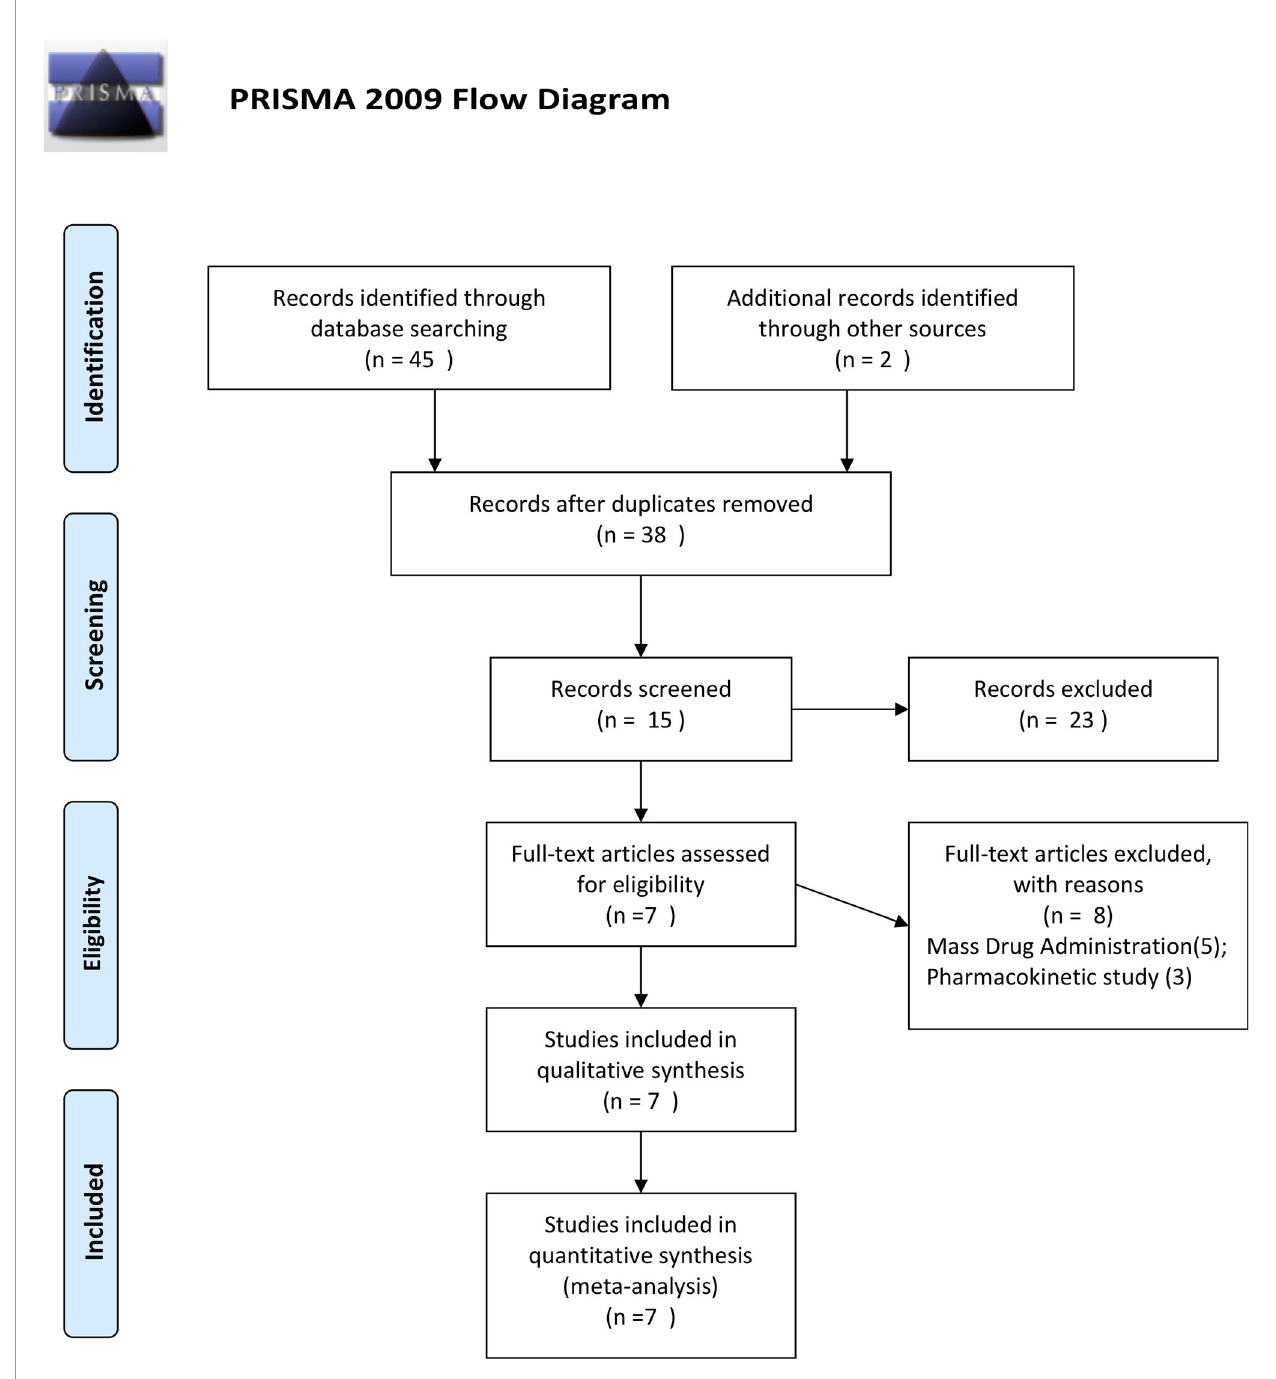
FIGURE 1 | PRISMA fl ow for data